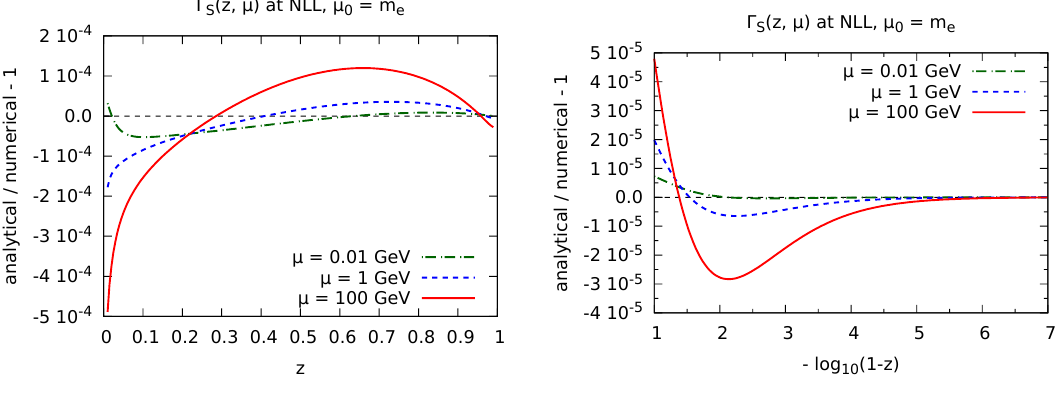
Figure 7 . As in (cid:12)gure 6, for the